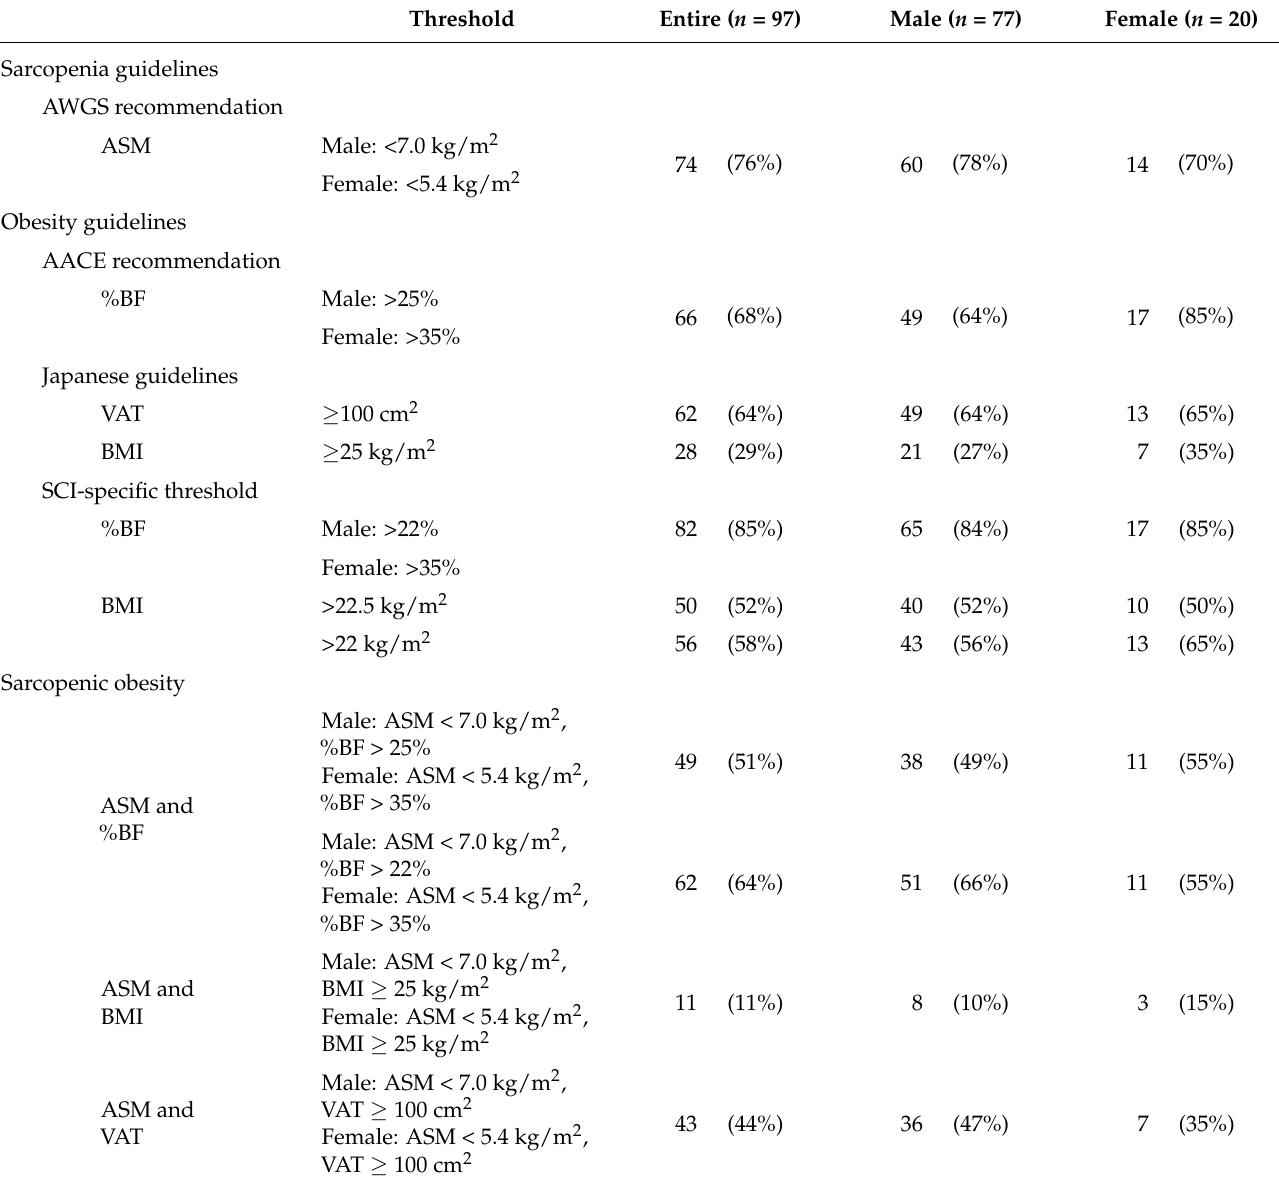
Table 4. Prevalence of obesity, sarcopenia, and sarcopenic obesity based on the general and SCI- specific thresholds. Threshold Entire ( n = 97) Male ( n = 77) Female ( n =